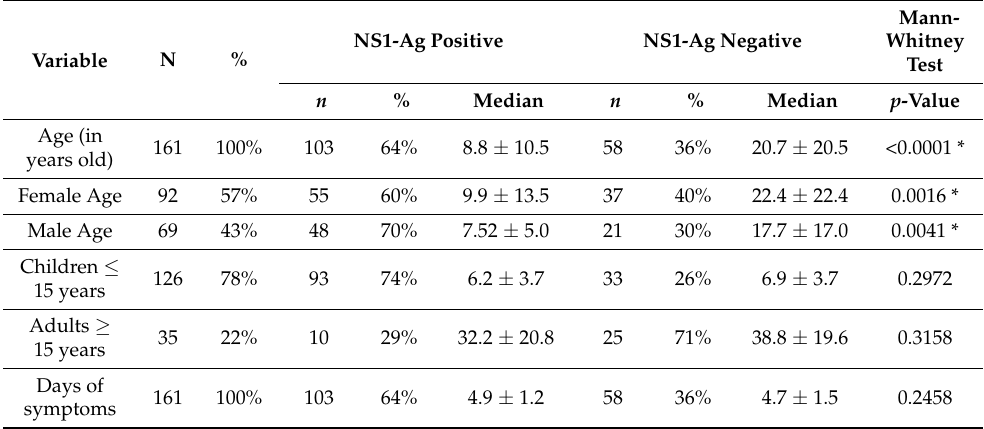
Table 1. Epidemiological characteristics in patients with positive and negative DENV-NS1-Ag tests. Hospital Local de Los Patios, Norte de Santander, Colombia, 2018.